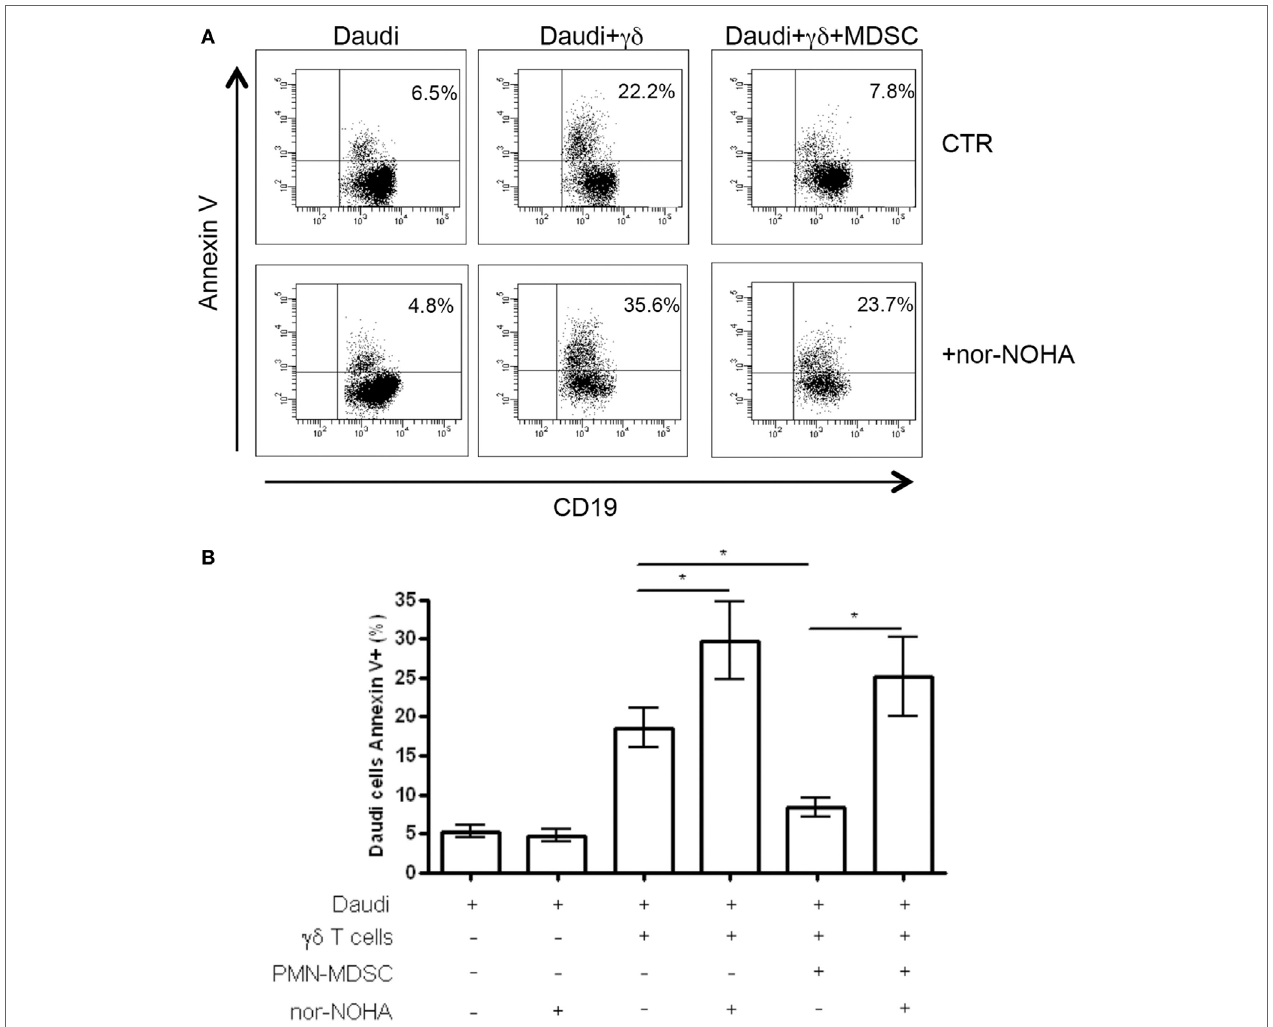
FigUre 6 | ArgI is involved in V δ 2 T suppression . Daudi cells were cultured with purified γδ T cells in the presence of PMN-MDSC (1:2:2 ratio) and 1 mM of nor-NOHA. After 18 h apoptotic (Annexin V + ) Daudi cells were evaluated by flowcytometry. (a) Representative dot plots showing Annexin V + Daudi cells (CD19 + ) in the indicated conditions. (B) Percentage of Annexin V + CD19 + Daudi cells in the indicated conditions. Results are show as mean + SEM of three independent experiments (* p <